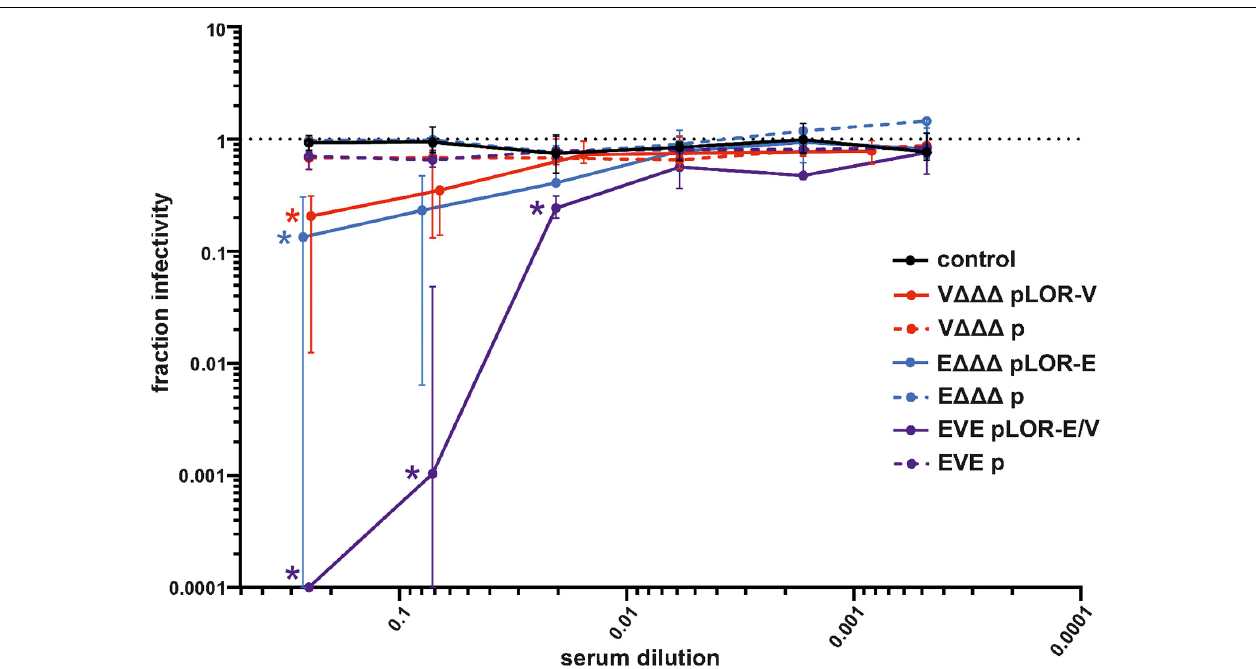
FIGURE 7 | Neutralization assays with sera from OMV-immunized mice. Shown is the median fraction of infectivity using a Spike-pseudotyped lentivirus neutralization assay in combination with sera collected at day 60 from mice of the respective immunization groups as indicated ( n = 7 for each group). Starting with a 1:4 dilution, 3.5-fold serial dilutions of each sera were tested. The error bars indicate the interquartile range of each data set. The limit of detection in these assays was a fraction of infectivity = 0.0001. Overlapping median values and error bars were slightly nudged on the x -axis to allow better visualization. Significant reductions of infectivity compared to the sham-immunized control group are marked by asterisks in the color of the respective data set and were observed for the following data sets: V (cid:49)(cid:49)(cid:49) pLOR-V and E (cid:49)(cid:49)(cid:49) pLOR-E for the 1:4 serum dilution as well as EVE pLOR-E/V for the 1:4, 1:14, and 1:49 dilution ( p < 0.05; Kruskal–Wallis test and post hoc Dunn’s multiple